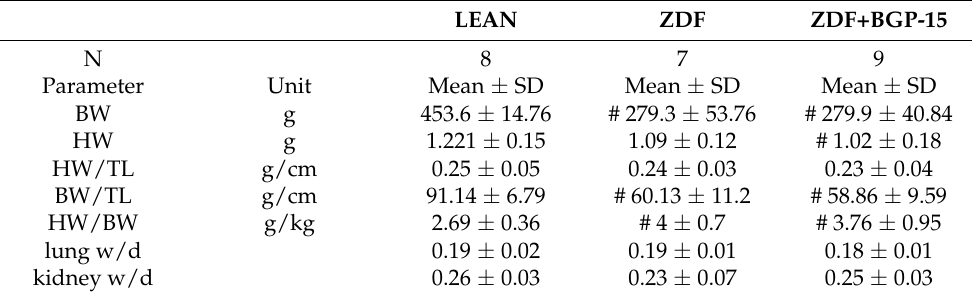
Table 1. Bodyweight, heart weight (BW, HW) to tibia length (TL) ratios, lung and kidney wet (w) to dry (d) tissue ratios at the endpoint of the